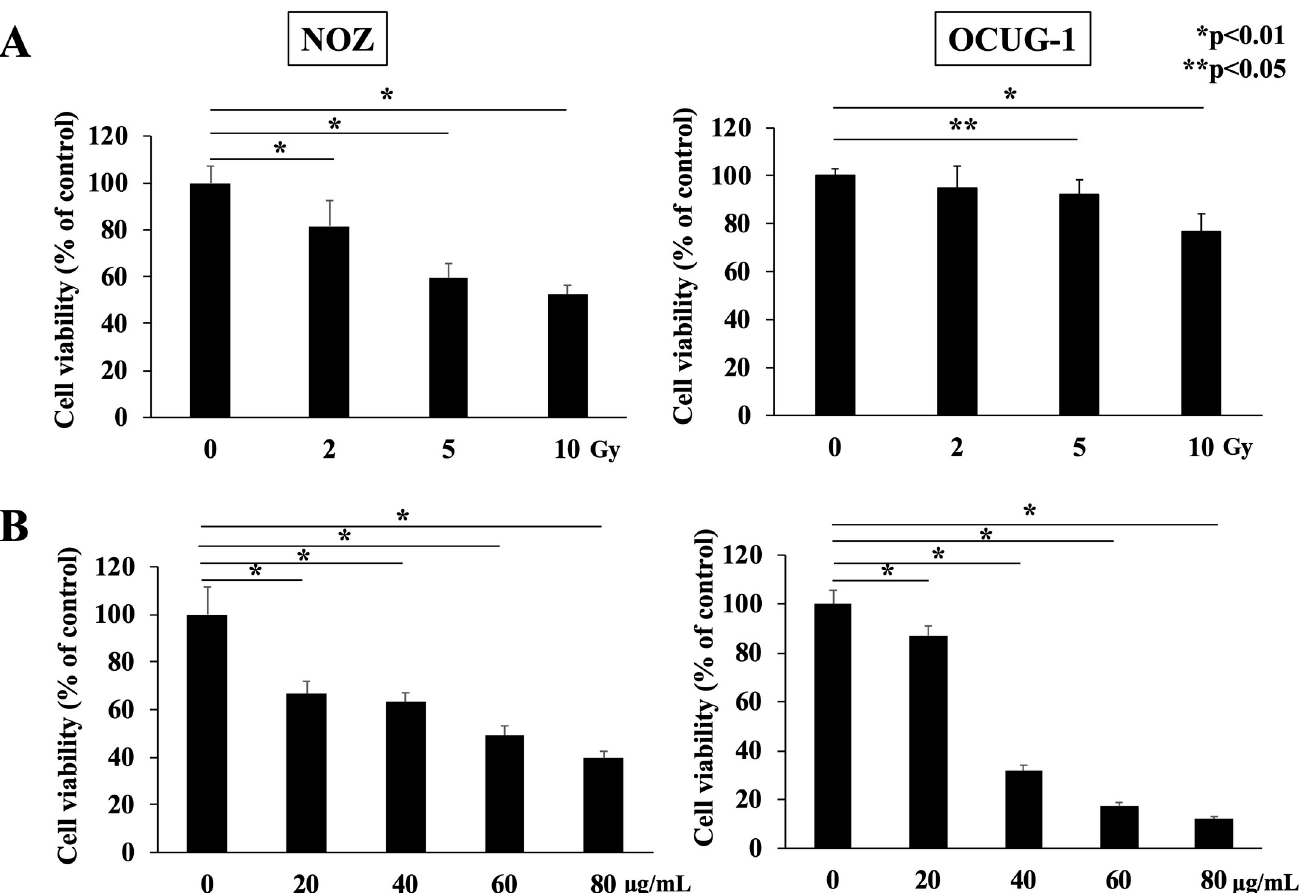
Fig 1. Cell viabilities of NOZ and OCUG-1 cells treated with radiotherapy or NM. (A) Cell viability was suppressed by radiotherapy in a dose-dependent manner (NOZ: 0 Gy: 100.0 ± 7.1%; 2 Gy: 81.7 ± 10.8%; 5 Gy: 59.5 ± 6.1%; 10 Gy: 52.7 ± 3.7%, OCUG-1: 0 Gy: 100.0 ± 3.0%; 2 Gy: 94.6 ± 9.5%; 5 Gy: 92.0 ± 6.4%; 10 Gy: 77.1 ± 7.1%) at 96 h after irradiation. (B) Cell viability was suppressed by NM in a dose-dependent manner (NOZ: 0 μ g/mL: 100.0 ± 11.5%; 20 μ g/mL: 66.7 ± 5.2%; 40 μ g/mL: 63.3 ± 3.8%; 60 μ g/mL: 49.2 ± 4.0%; 80 μ g/mL: 39.6 ± 2.9%, OCUG-1: 0 μ g/mL: 100.0 ± 5.6%; 20 μ g/mL: 87.7 ± 3.9%; 40 μ g/mL: 31.8 ± 2.2%; 60 μ g/mL: 17.4 ± 1.3%; 80 μ g/mL: 12.2 ±